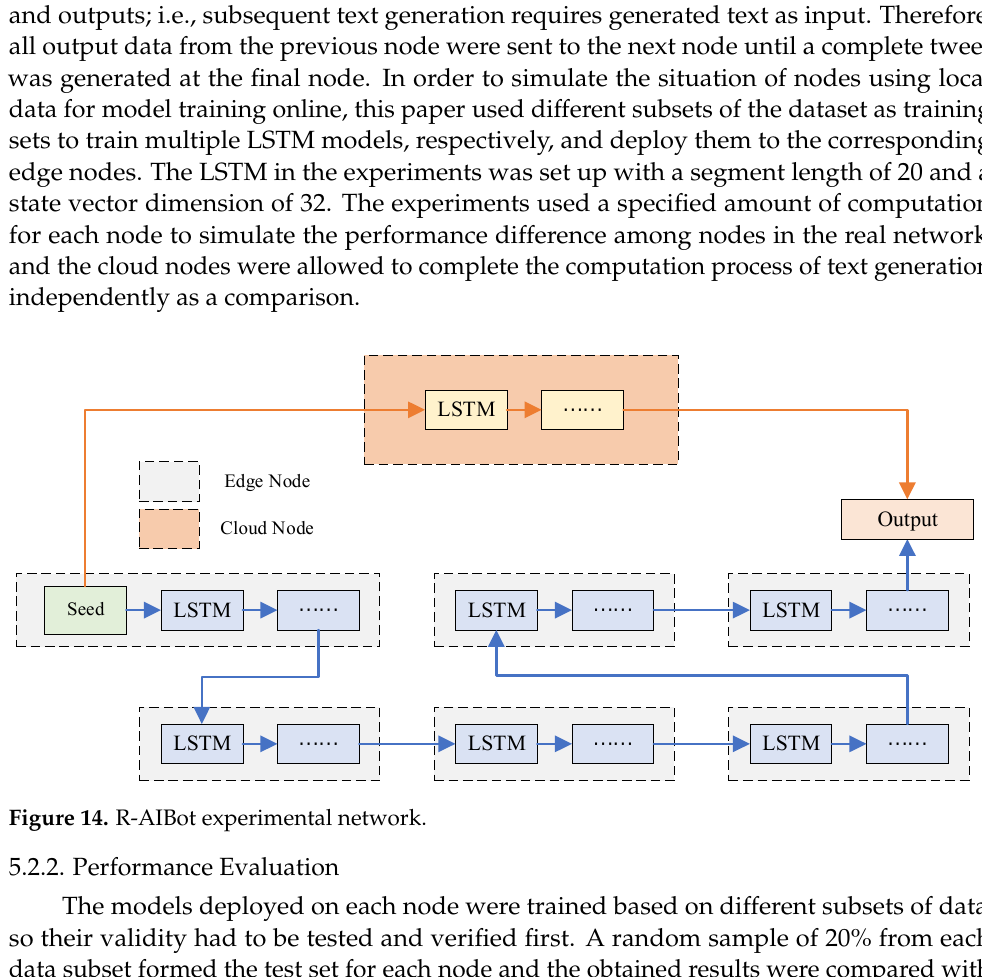
Figure 14. R-AIBot experimental network.